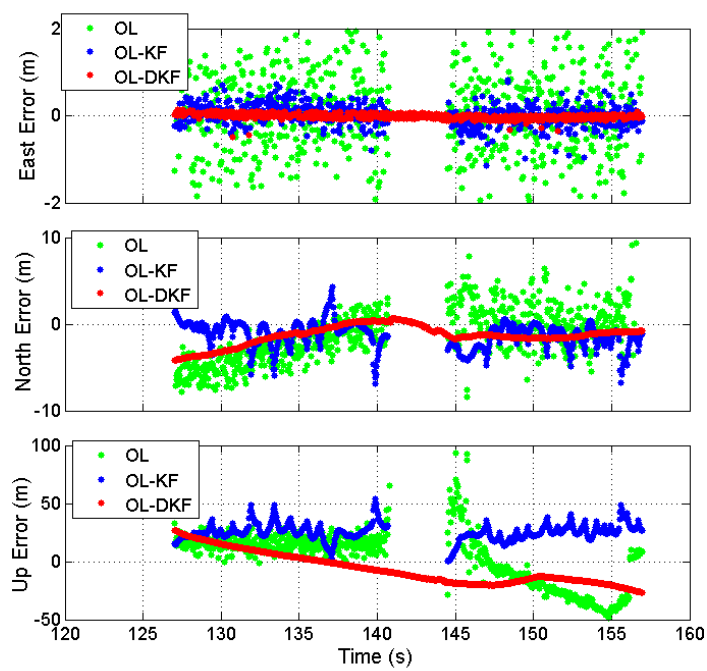
Figure 25. Three-dimensional errors of roads blocked by a light railway test.